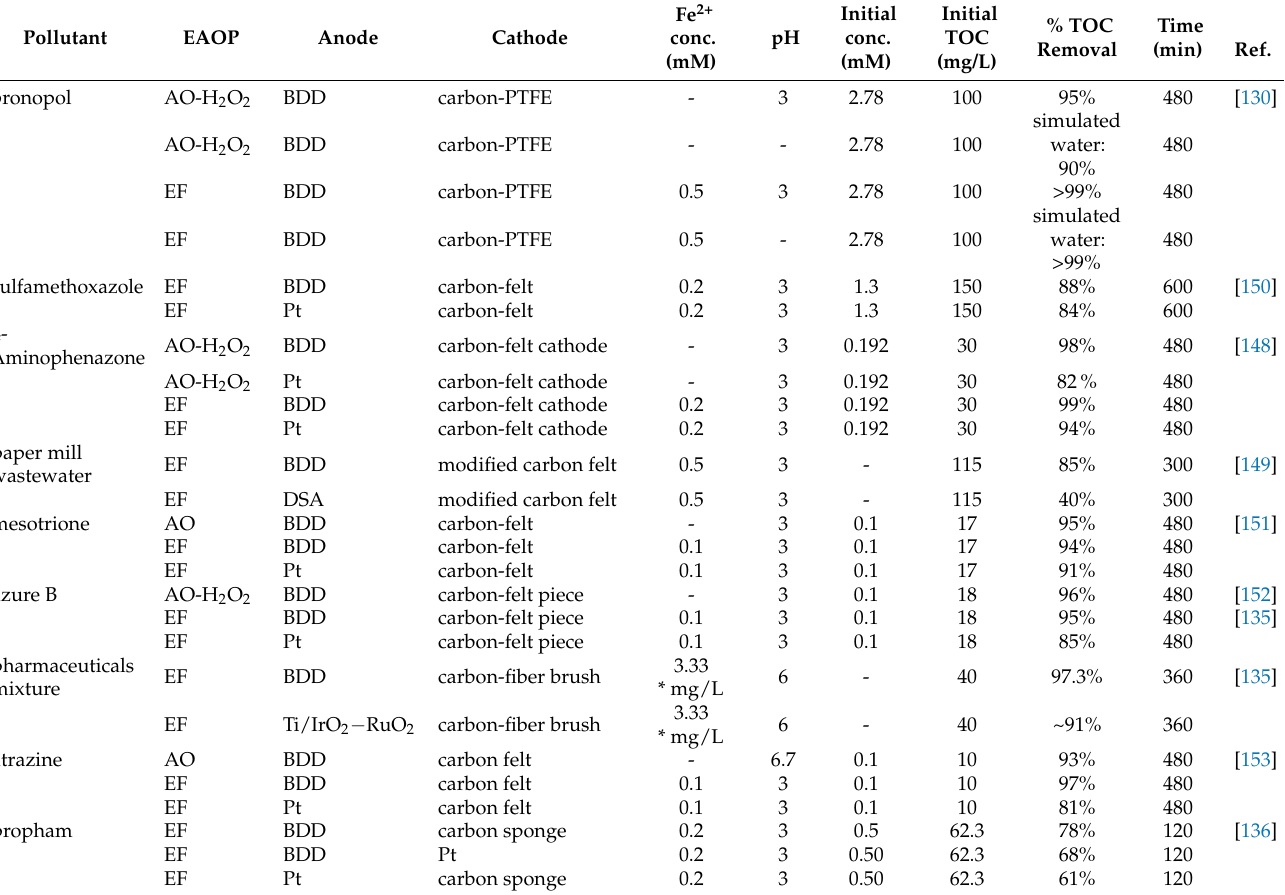
Table 5. Examples of studies that applied BDD anodes to treat pollutants by electro-Fenton